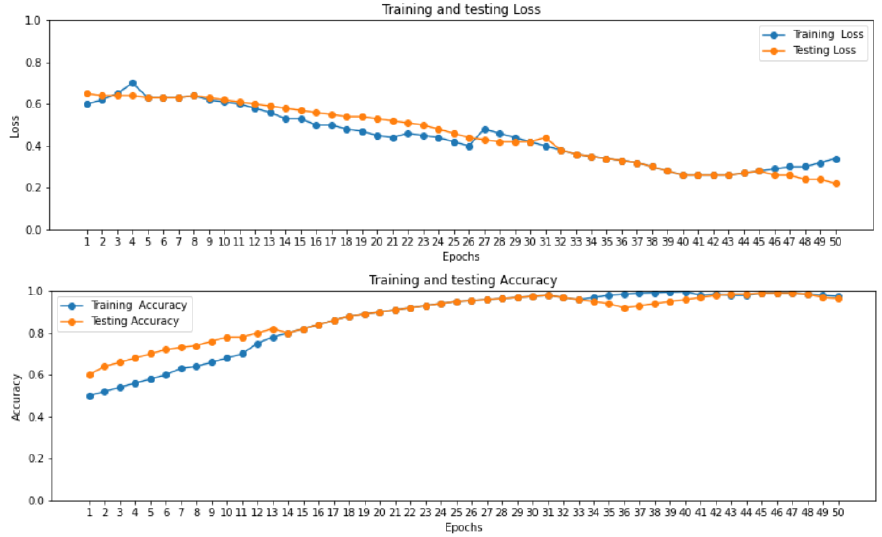
Figure 3. Loss and Accuracy curve of proposed ensemble learning model with Self consistency test.